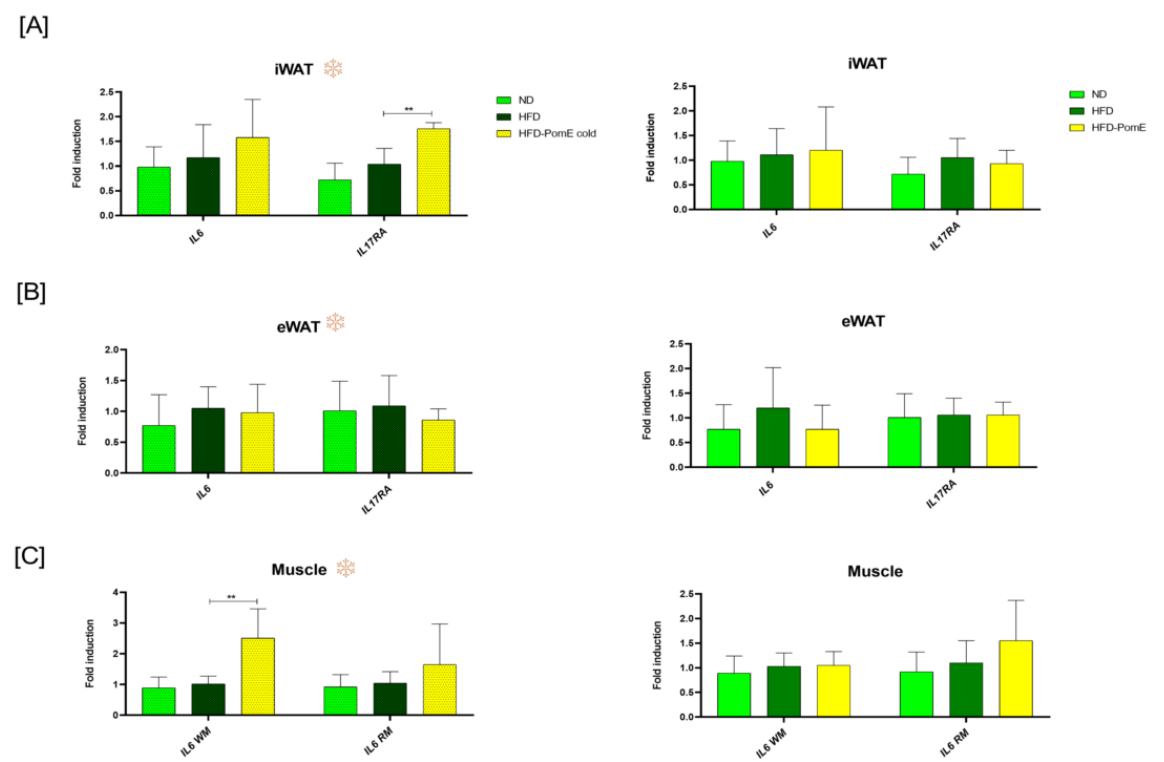
Figure 7. Gene expression levels of the thermogenic IL17AR in the ( A ) inguinal white (iWAT) and ( B ) epididymal white (eWAT) adipose tissues, and ( C ) the myokine IL6 in white (WM) and red (RM) muscle tissues, of HFD-control and HFD-PomE groups, exposed or not to cold stress (N = 4–8). Statistically significant values are indicated with asterisks based on their p- value, ** p < 0.01.